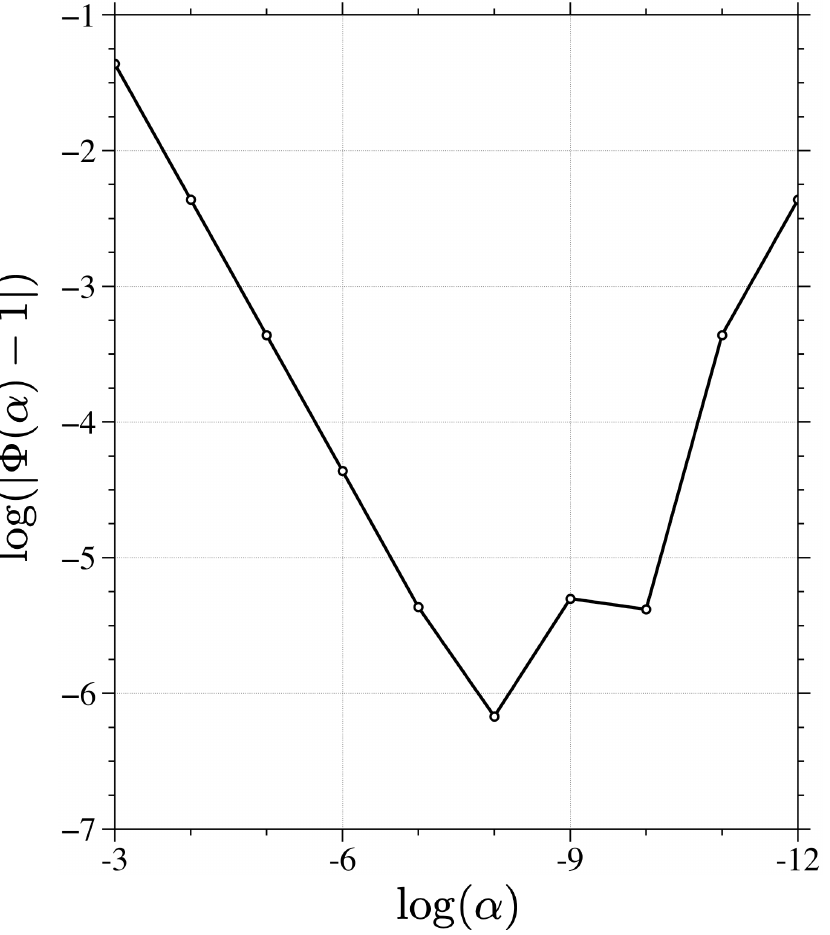
Figure 5. Variations in the gradient-check results log ( | Φ ( α ) − 1 | ) as a function of the log of the scaling factor α Fig. 5: Variations in the gradient-check results as a function of the log of the scaling factor .